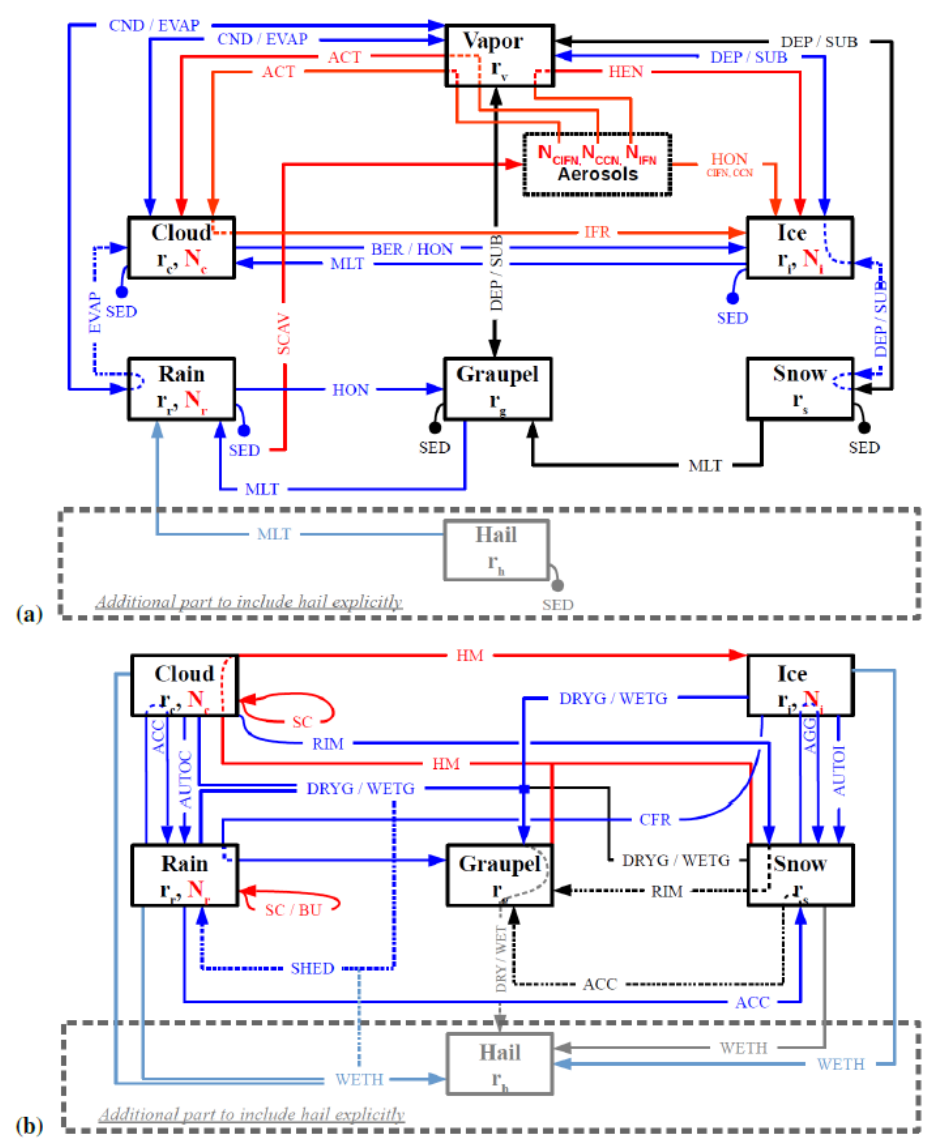
Figure 7. Diagrams of the microphysical processes of ICE3–ICE4 and LIMA: (a) all the processes except collection; (b) collection processes. Blue arrows represent existing processes in ICE3 modified in LIMA, red arrows are new processes in LIMA, and black arrows are identical processes in ICE3 and LIMA. When hail is a full sixth category (in ICE4 and LIMA), processes are in muted colors. Prognostic variables for all the hydrometeor species are written in the boxes, with r the mixing ratio and N the